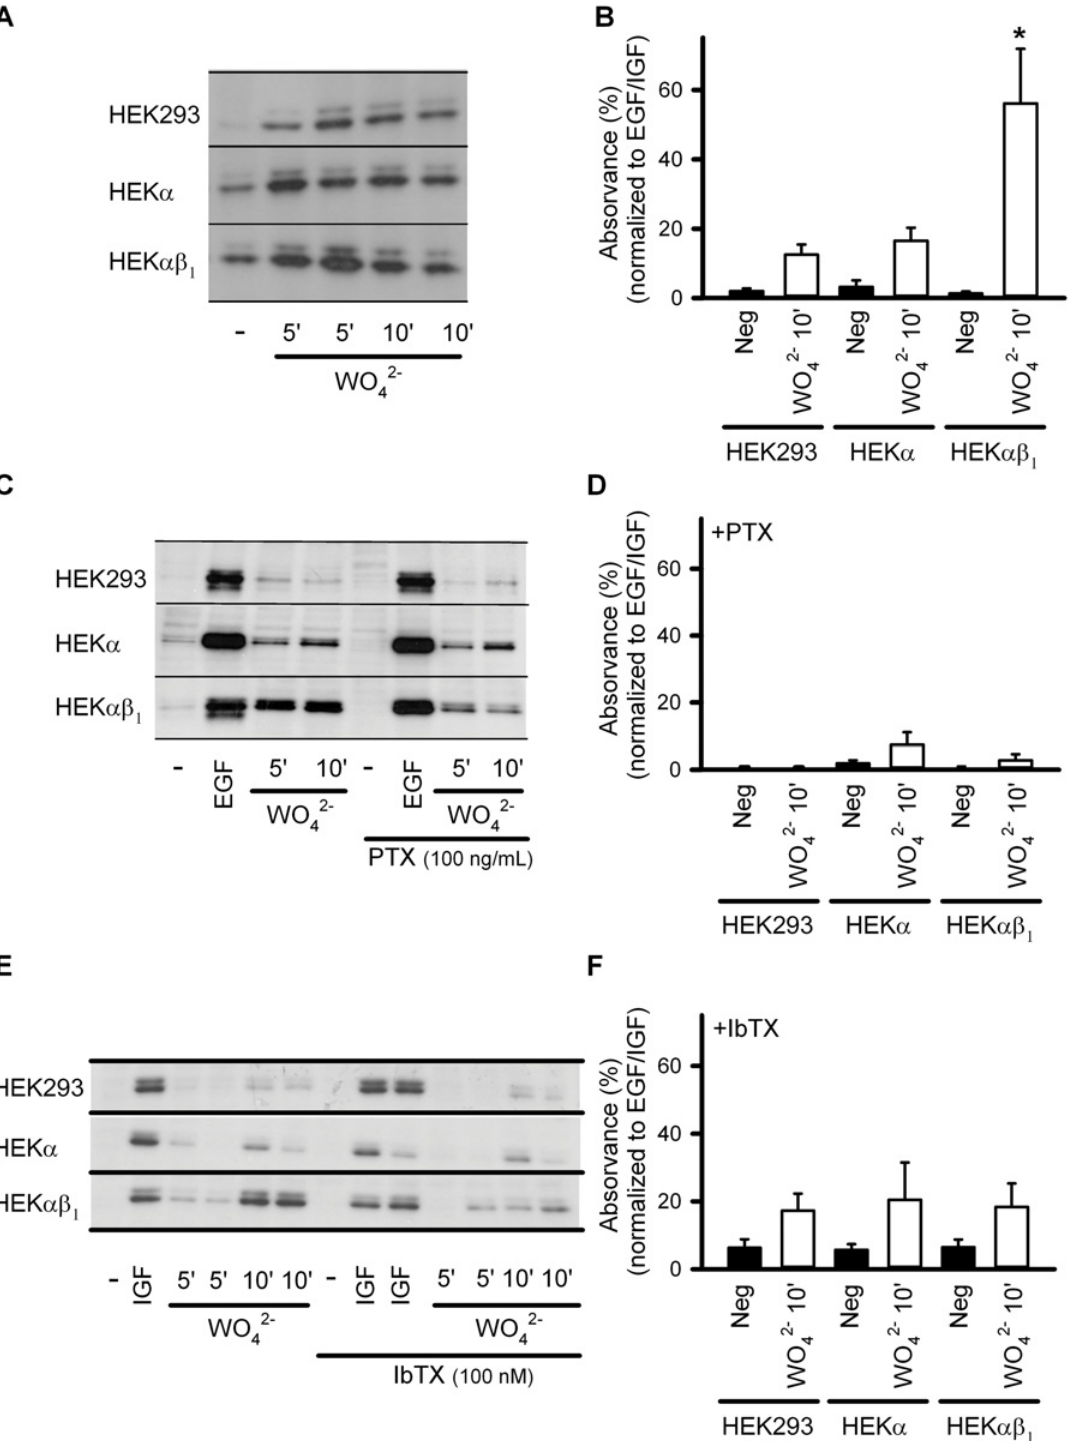
Fig 1. BK αβ 1 channels potentiate tungstate-induced ERK1/2 phosphorylation in a G i/o protein-dependent manner. Phosphorylation of ERK1/2 was analyzed by Western blot using phospho-ERK-specific antibodies. Total ERK was used as loading control (data not shown). Protein expression and phosphorylation were quantified by densitometry of the corresponding Western blot signal. Relative density (phosphorylated versus total ERK) was normalized to the inner control (EGF/IGF for each condition, which was considered as 100%). (A) Representative Western blots obtained from HEK293, HEK α and HEK αβ 1 cells for ERK1/2 phosphorylation levels, without treatment (-) or after treatment with 1 mM tungstate (WO 42- ) (during 5 and 10 minutes, as